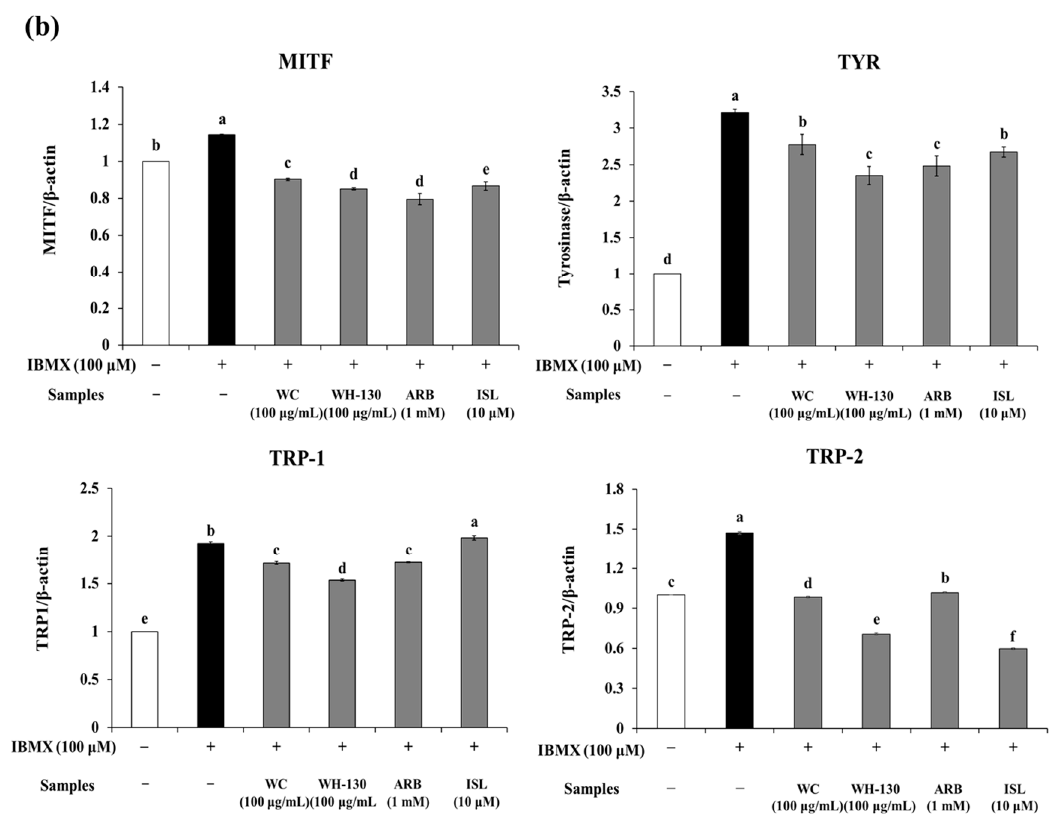
Figure 7. Effects of licorice extracts (WC and WH-130) on the expression of melanogenesis-related proteins in B16F10 cells. Cells were treated with licorice extracts (WC and WH-130), arbutin (ARB, 1 mM) and isoliquiritigenin (ISL, 10 µ M) for 48 h. ( a ) Expression levels of proteins including MITF, TYR, TRP-1 and TRP-2 were determined through a western blotting assay (densitometric data). Equal protein loading was confirmed with β -actin as a housekeeping protein. ( b ) Values are presented as mean ± SD from three experimental replicates. Significance was statistically defined with small letters at p < 0.05.